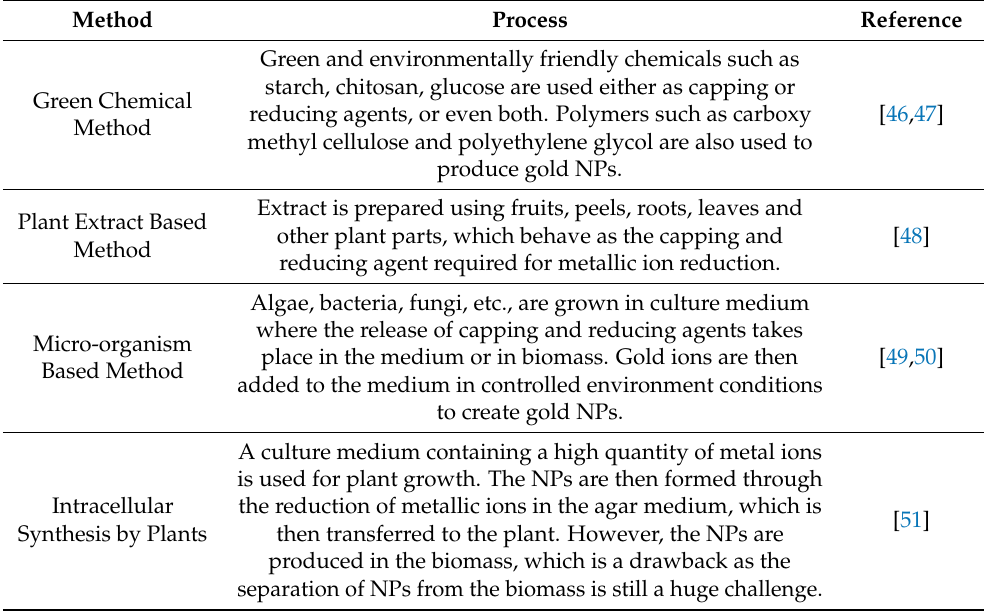
Table 2. Summary of the natural products and the processes involved in the preparation of gold NPs.